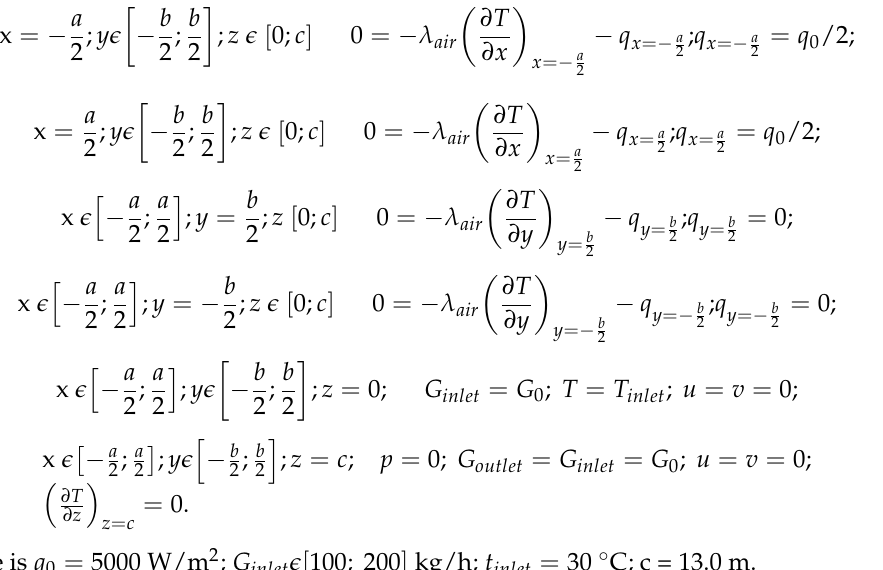
Notes Symmetrical